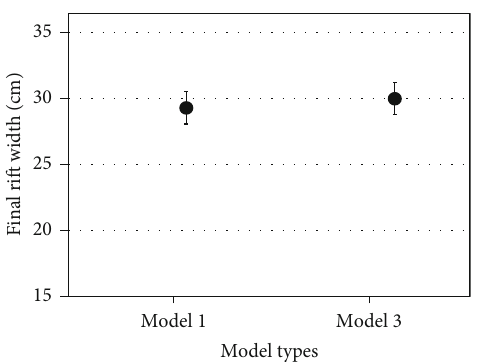
Figure 8: Final rift segment width as a function of extension, measured from the model surface.